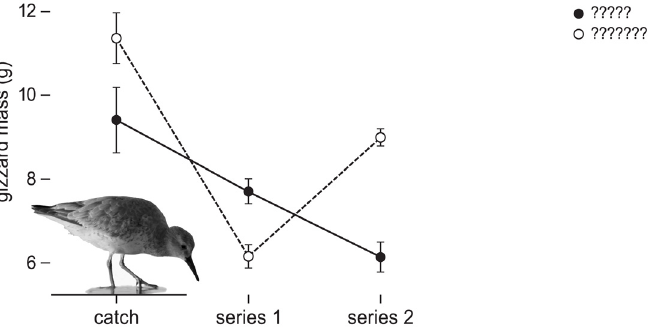
Fig 1. Mean gizzard mass of birds directly after catch, during the first and second series of trials. Directly after catch, the 6 red knots were randomly divided into two groups, group 1 (solid dots and line) and group 2 (open dots and dashed line). Both groups received different diets outside the experimental trials (soft or hard-shelled prey) to manipulate gizzard size. Initial differences in gizzard mass between groups were not significant (F 1,4 = 3.9,p = 0.12). After catch, all birds decreased gizzard mass, but group 1 had larger gizzards than group 2 during the first series of trials, and smaller gizzards during the second series (Table 2, models 1.1 to 1.5), showing that the manipulation of gizzard size was successful. Each group consisted of three birds. However, data collected on one bird from group 2 after it became sick during series 2 was omitted from the graphs and the analysis. Error bars show standard